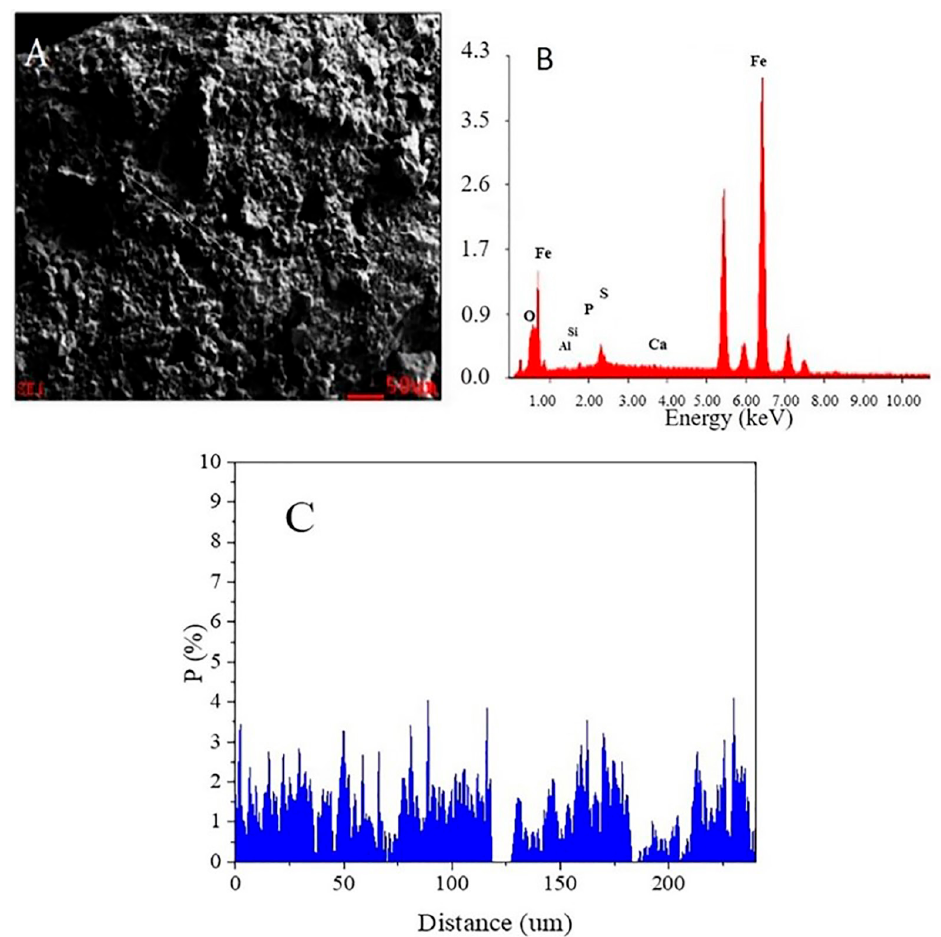
Figure 9. Micrographs of ore fines with a mean particle size of 0.35 mm treated by microwave energy (A) graphs of particle surface composition (B) and distribution of phosphorus along the particle